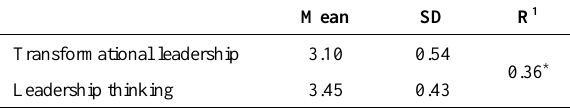
Table 8. Correlation between transformational leadership style and leadership